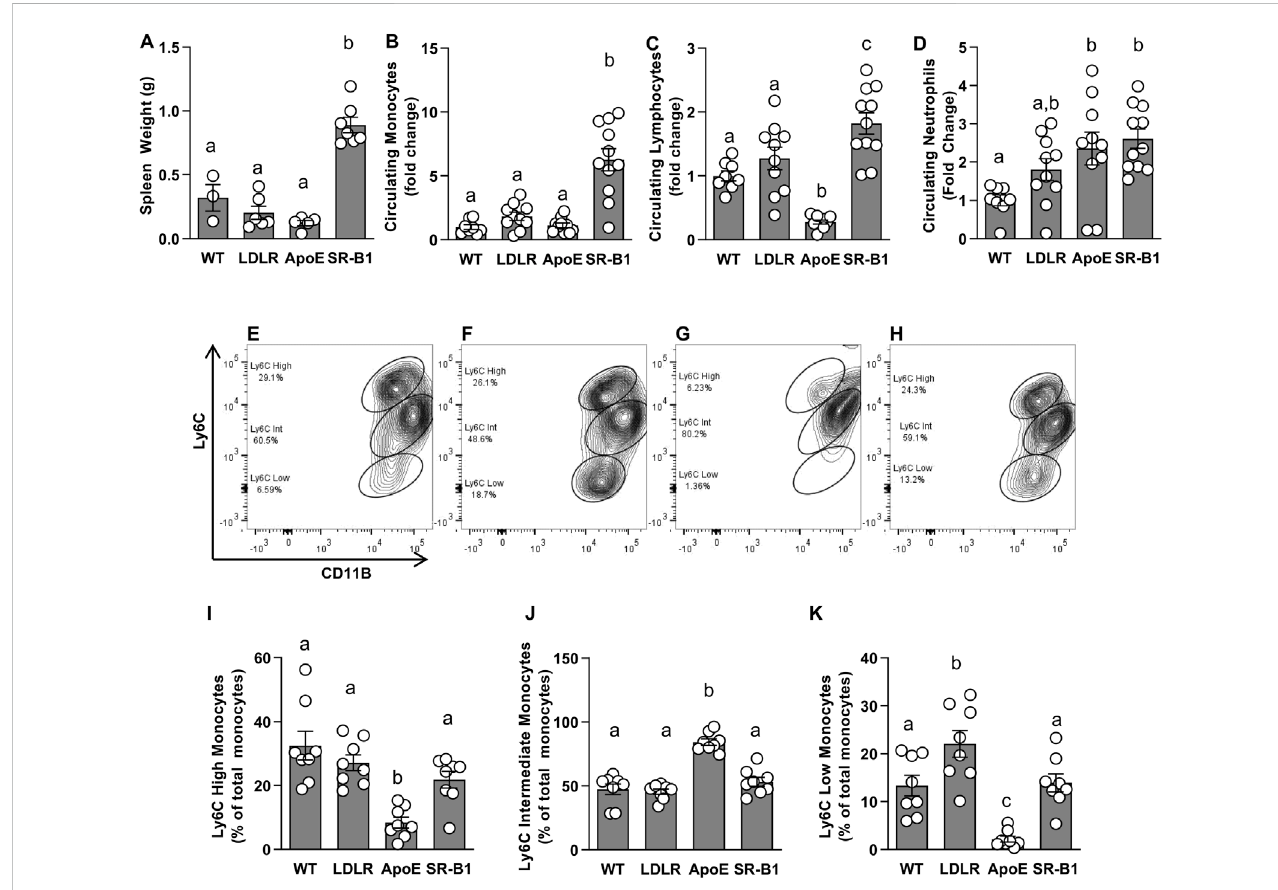
FIGURE 4 Circulating immune cells in HFCC-fed female WT, LDLR KO, ApoE KO and SR-B1 KO mice. (A) Spleens were collected and weighed after 20 weeks of HFCC feeding. Blood cells were analyzed from whole blood collected from the tail veins of mice after 6 weeks of HFCC feeding using a Hemavet Multi- speciesCellAnalyzer (B – D) or fl owcytometry (E – K) .Averagelevels±SEMofcirculatingmonocytes (B) lymphocytes (C) andneutrophils (D) ineachgenotype group are shown, normalized to levels observed in WT mice ( N = 8 – 11 per group). For fl ow cytometry, CD11b (shown) and CD115 double positive monocyteswereanalyzedforlevelsofLy6Cexpression.RepresentativecytogramsillustratingLy6CexpressionpatternsinmonocytesC57B6 (E) ,LDLRKO (F) , ApoE KO (G) and SR-B1 KO (H) mice. Flow cytometry data was analyzed using FloJo software. Graphs represent proportions of Ly6C High (I) , Ly6C Intermediate (J) andLy6CLow (K) monocytesubsetsinblood( N =8pergroup).Individualsymbolsrepresentsamplesfromindividualmiceandbarswitherror bars represent average ± SEM of each group. The different letters indicate groups that are statistically signi fi cantly different from one another by one-way ANOVA with Tukey ’ s post-hoc test. (A) Overall ANOVA: p < 0.0001; multiple comparisons: p < 0.0001 for a vs. b; (B) Overall ANOVA: p = 0.0002; multiple comparisons: p < 0.001 for a vs. b; (C) Overall ANOVA: p < 0.0001; multiple comparisons: p < 0.005 for a vs. b; p < 0.03 for a vs. c; p < 0.0001 for b vs. c; (D) Overall ANOVA: p = 0.005; multiple comparisons: p < 0.025 for a vs. b; (I) Overall ANOVA: p < 0.0001; multiple comparisons: p < 0.02 for a vs. b; (J) Overall ANOVA: p < 0.0001;multiplecomparisons: p < 0.0001foravs.b; (K) OverallANOVA: p < 0.0001;multiplecomparisons: p < 0.04for avs.b; p < 0.003for bvs . c; p < 0.002 for a vs.